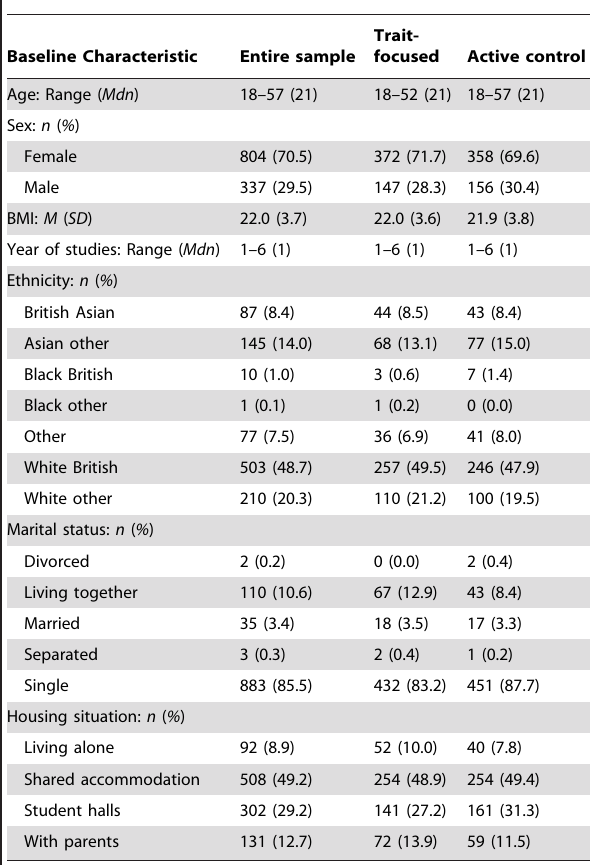
Table 2. Demographic Characteristics of Participants at